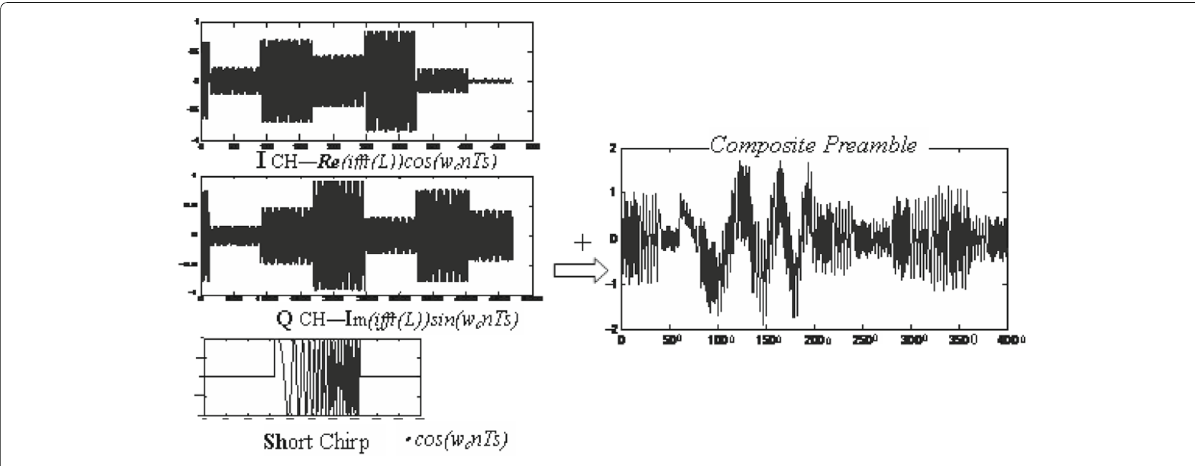
Fig. 6 FDTD excitation source settings FDTD simulation platform, which is China’s first paral- lel all-vector electromagnetic simulation platform. The platform is based on a strict FDTD and physical optics model; its calculation speed is 10 to 100 times higher than similar algorithms found worldwide. The parameters